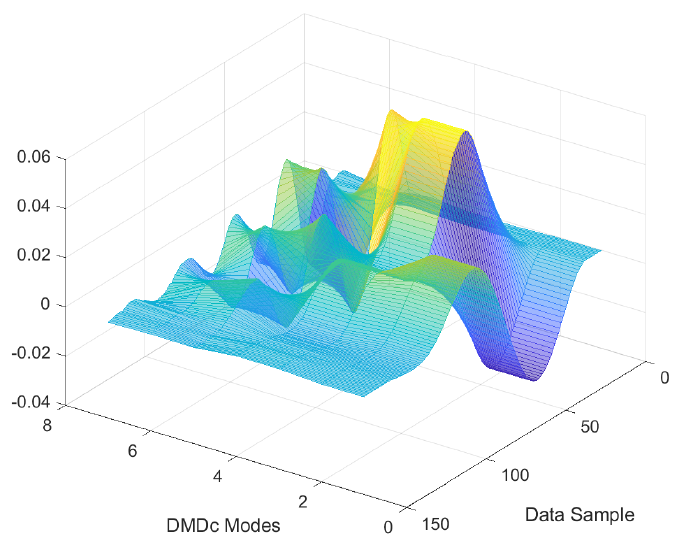
Figure 7. Combination of seven DMDc modes within one transient of the square reference